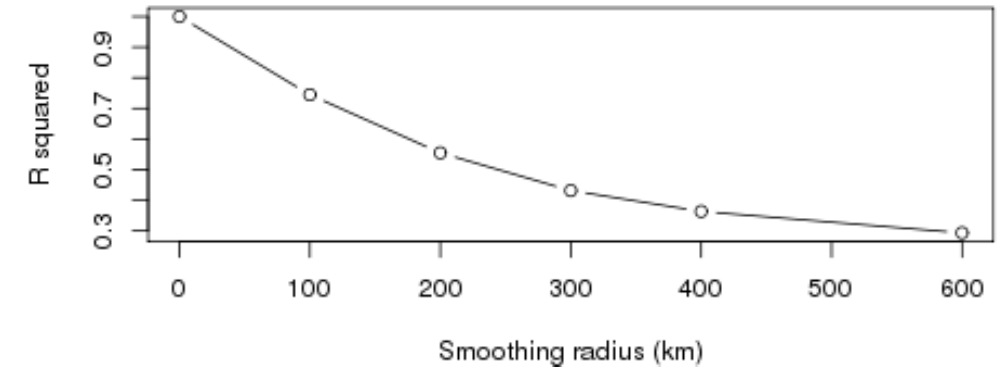
Figure 8. Correlation between rainfall at a point at 25°E 15°S and mean rainfall in a box surrounding the point (y-axis), plotted as a function of the length of the side of the box (x-axis).